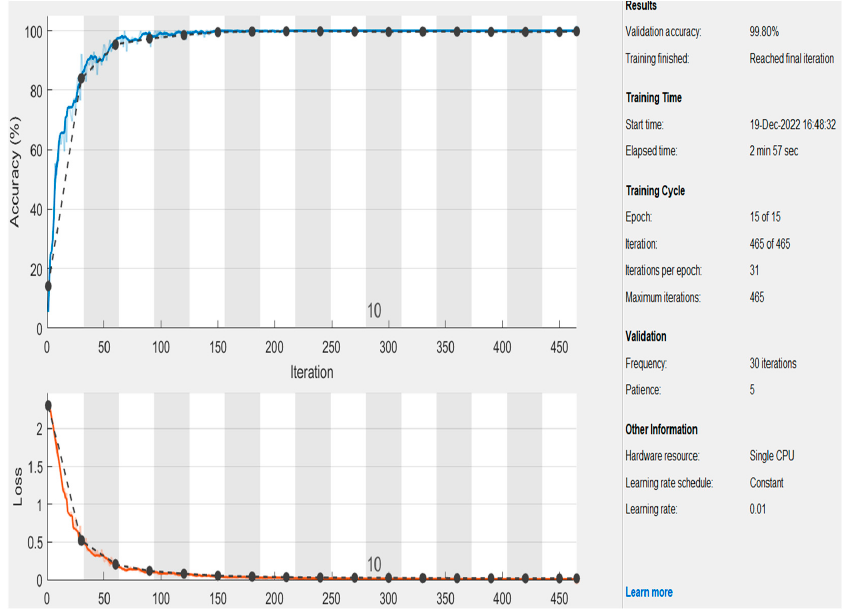
Figure 5. The achieved results of accuracy and the loss function using L a .